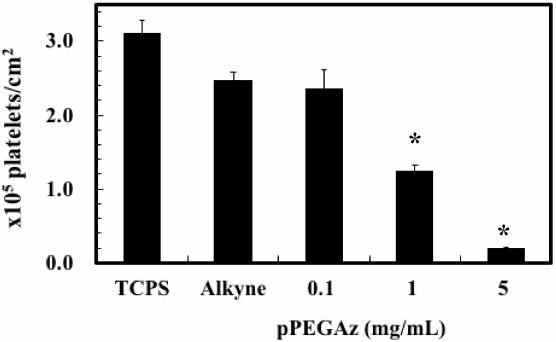
Figure 4. Alkyne-PPX was deposited on TCPS and then conjugated with pPEGAz at various concentrations (0.1, 1, and 5 mg/mL). Platelets were allowed to attach on the various substrates for one hour. Value = mean ± standard deviation, n = 5. * p < 0.001, compared to the platelet adhesion to